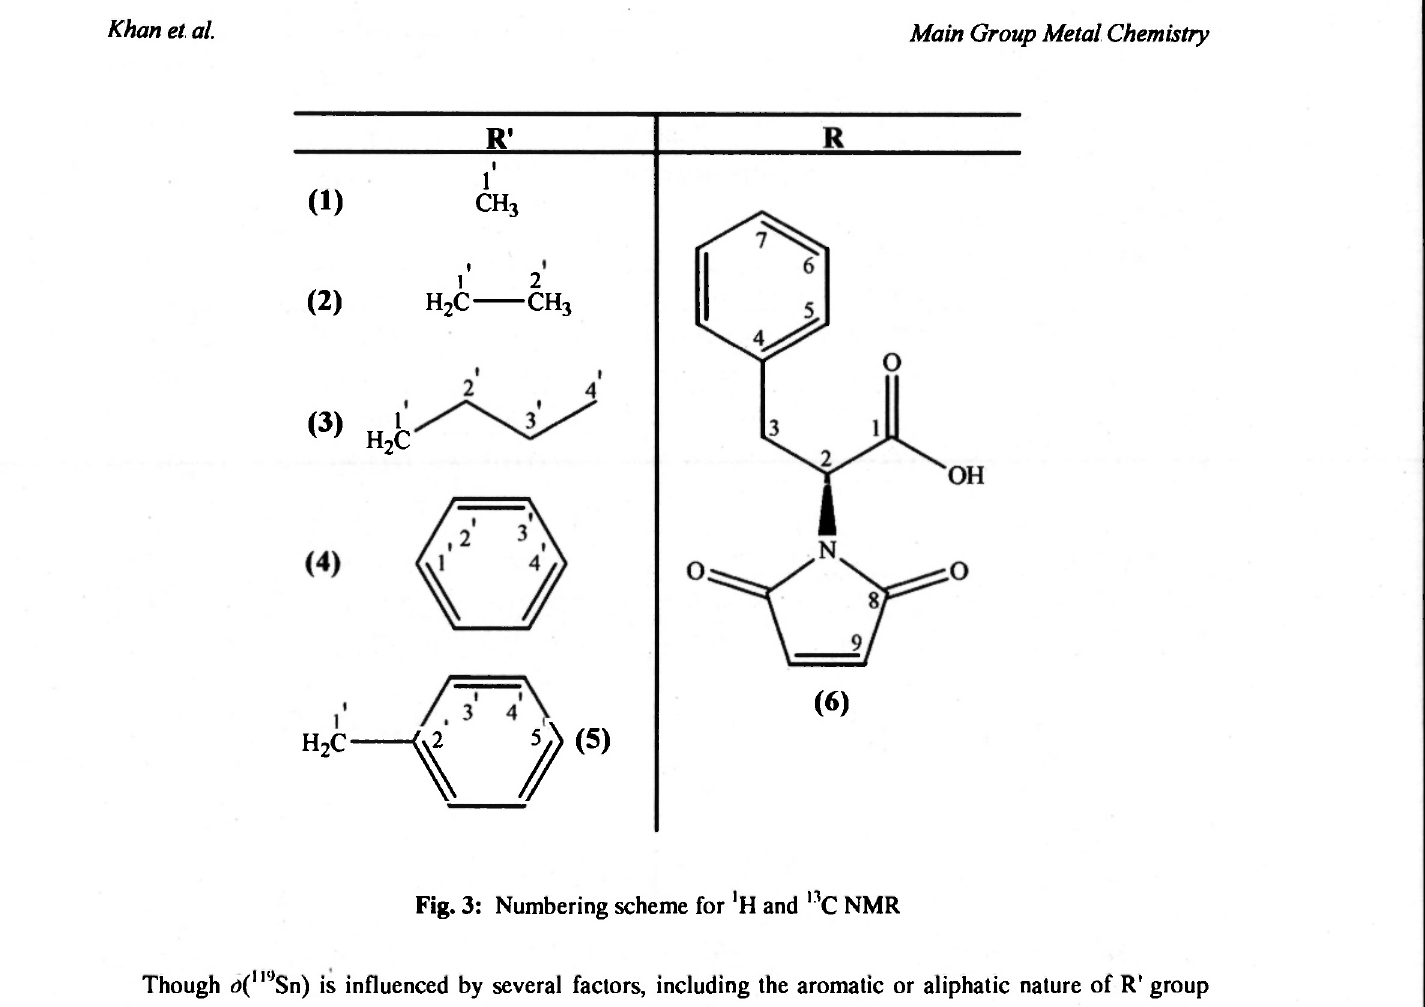
Fig. 3: Numbering scheme for 'Η and "C